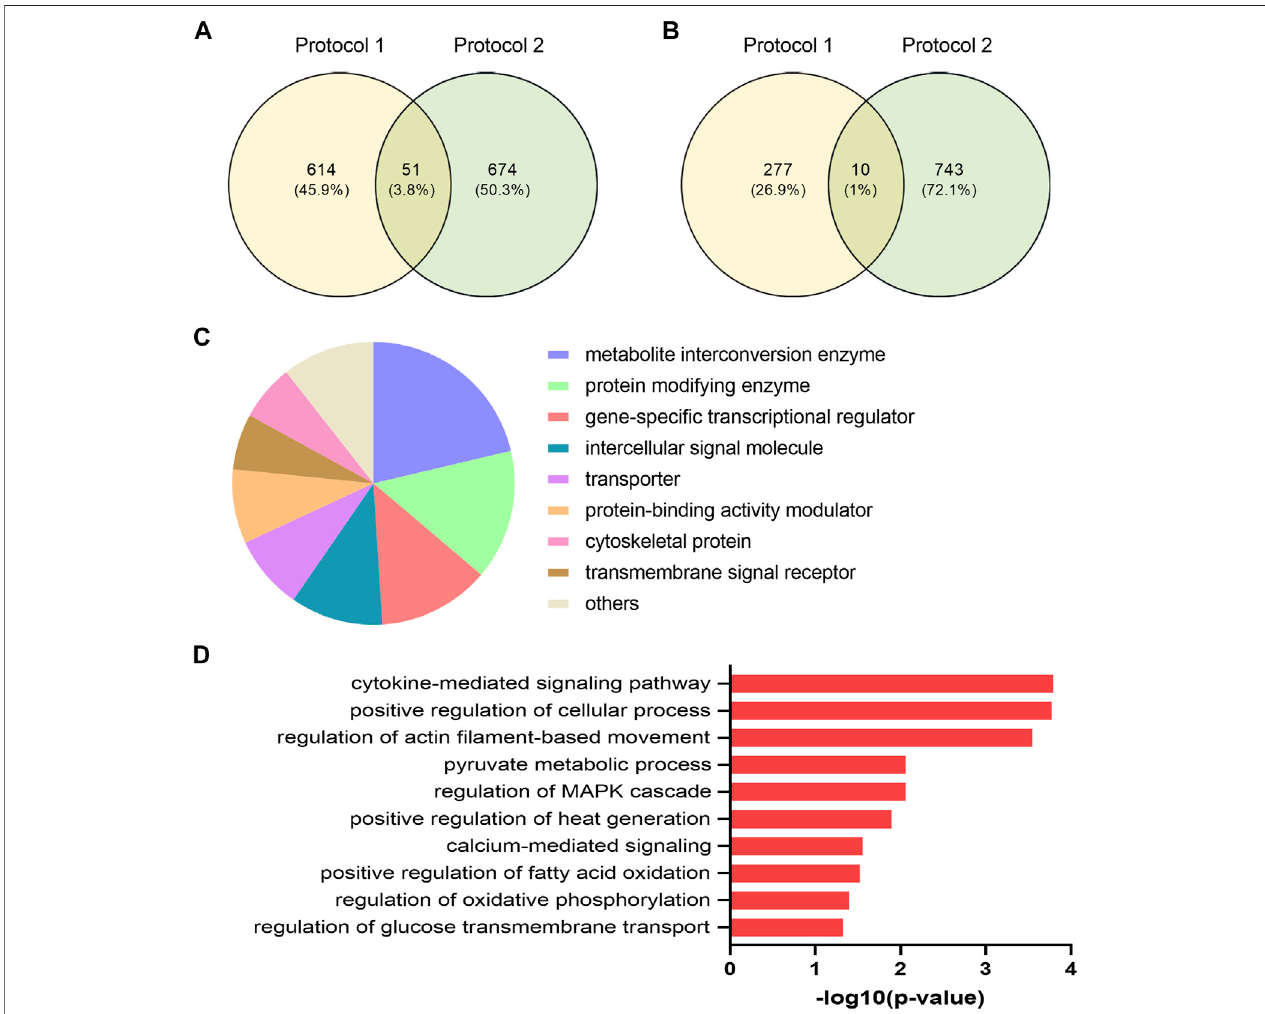
FIGURE 6 | Functional classi fi cation and selected Gene Ontology (GO) enrichment of shared differentially expressed genes (DEGs) in myotubes from young male subjects and middle-aged women exposed to EPS protocol 1 and 2, respectively. Common upregulated (A) and downregulated (B) transcripts in both EPS protocols showedbyVenndiagram (C) Proteinclassescorresponding toallcommonlyshared DEGs (D) SelectedGOBiologicalProcess showingGOtermssigni fi cantlyenriched in the upregulated DEGs.